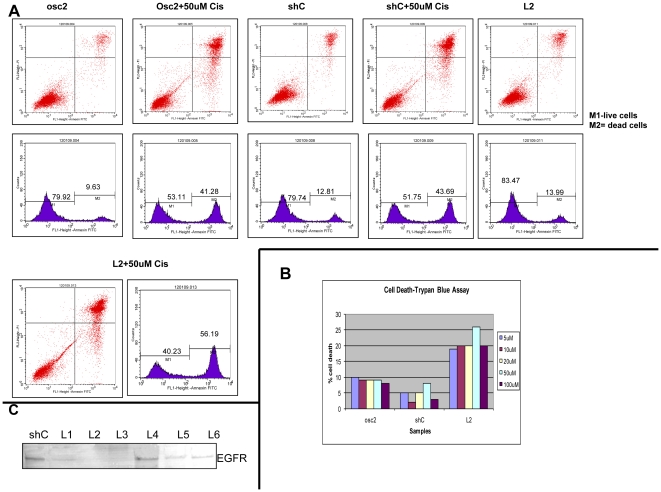

DSPP-silencing sensitizes OSC2 cells to cisplatin-induced apoptosis.(A) Treatment of DSPP-silenced L2, parental OSC2, and shC control cells with 50 uM for 24 h followed by Annexin V/FITC flow cytometry analysis show a 56.19% increase in apoptotic rate (measured by sub-G1 cellular DNA content) for L2 cells compared with 41.28% in parental with cisplatin and OSC2 and 43.69% in shC control with cisplatin. (B) Trypan blue staining bar chart quantitation indicates comparable apoptotic rates to that in (A). (C) WB showing significant down-regulation of EGFR in DSPP-silenced OSC2 cells, including L2. Symbols: Cis =  cisplatin; L2 =  DSPP-silenced OSC2 cells line 2; OSC2 =  parental (without knockdown) osc2 cells, M1 = live cells; M2 =  deal cells.